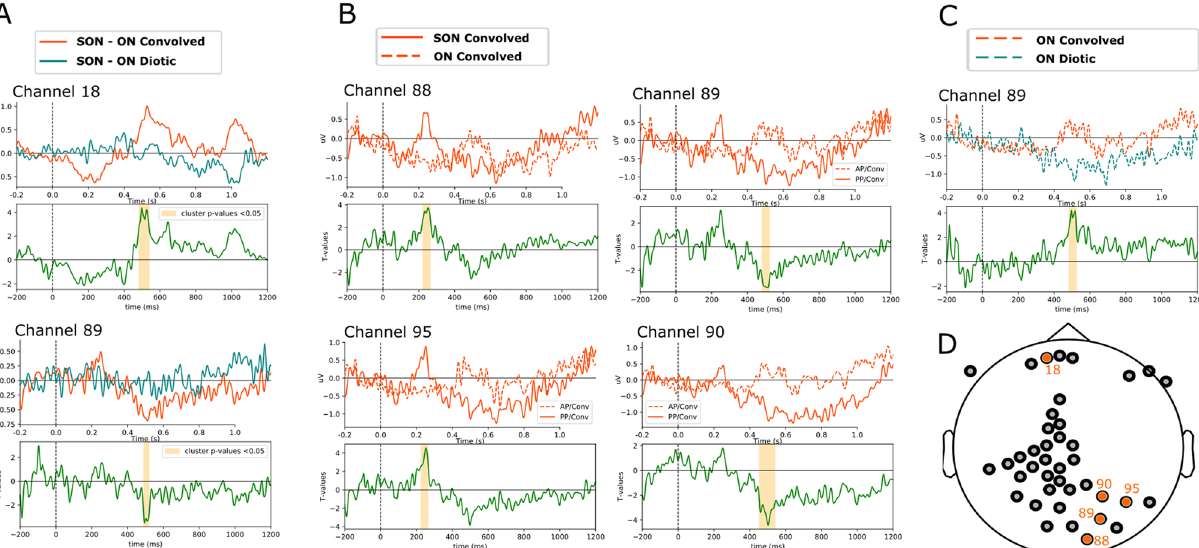
Figure 3. Comparison of evoked responses in patients. Comparison of evoked responses within patients in convolved (red) and diotic (teal) conditions for the own name (solid) and other names (dotted). Each channel figure consists of the comparison between indicated conditions (top) and the t-values of the difference in green (bottom) with significant cluster indicated in yellow. ( A) Comparison of differences between own and other names between convolved and diotic conditions (SONc-ONc vs SONd-ONd). (B) Comparison between the own and other names within the convolved condition (SONc vs ONc). (C) Comparison of the other name